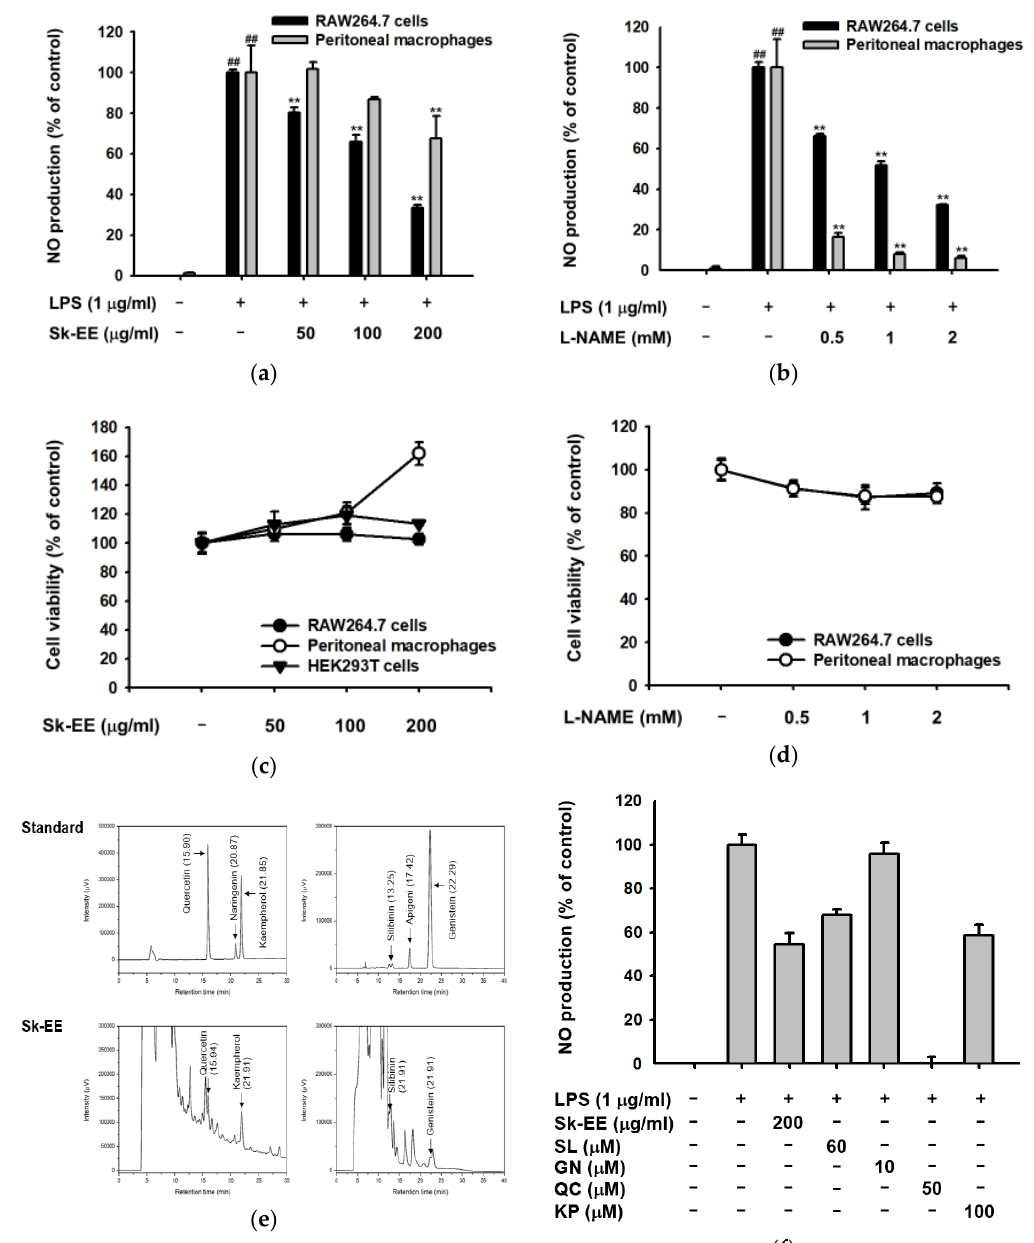
Figure 1. Effects of Sk-EE on nitric oxide (NO) production and its cytotoxicity analysis in macrophages. ( a , b ) RAW264.7 cells or peritoneal macrophages were pretreated with indicated doses of Sk-EE or L -NAME and induced by LPS (1 µg/mL) for 24 h. NO production was measured by Griess assay. ( c , d ) RAW264.7 cells, peritoneal macrophages, or HEK293T cells were treated with indicated doses of Sk-EE or L-NAME and their cell viability was determined by MTT assay. ( e ) Phytochemical characteristics of Sk-EE were analyzed via HPLC. ( f ) Detected flavonoids and Sk-EE were pretreated